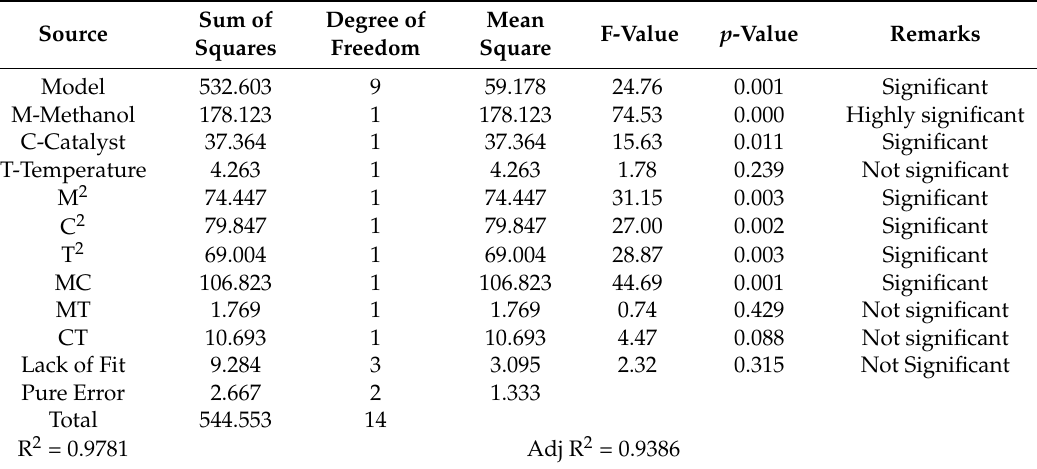
Table 9. ANOVA results for SFO